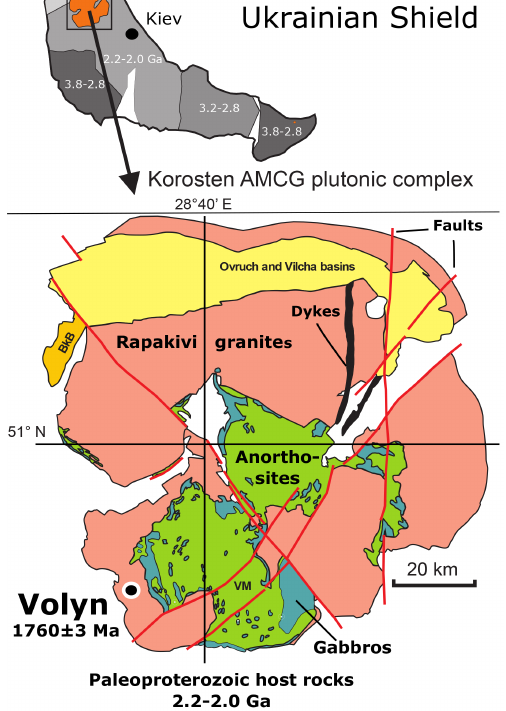
Figure 1. Location of the Volyn pegmatite field in the Ko- rosten anorthosite–mangerite–charnockite–granite plutonic com- plex, northwestern Ukrainian Shield (numbers refer to the ages in Ga of consolidation of the shield; Shumlyanskyy et al., 2017). The pegmatite age of 1760 ± 3Ma at Volyn refers to zircon U–Pb SIMS (secondary ion mass spectrometry) data (Shumlyanskyy et al.,